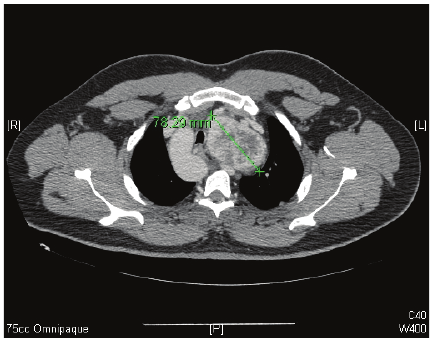
Figure 2: Axial CT scan with contrast at T4, showing retrosternal extension of the left thyroid lobe, with maximal diameter of 78 mm.